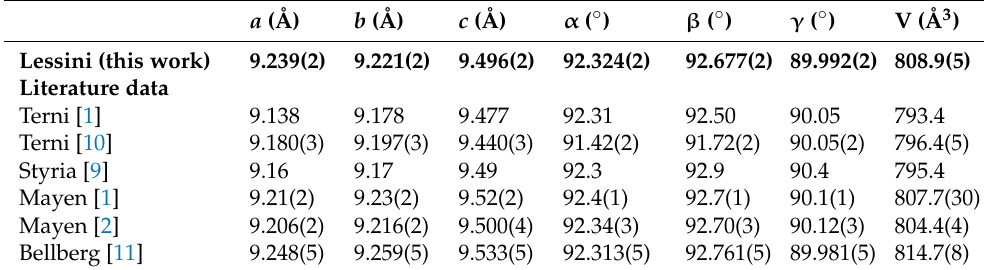
Table 4. Unit-cell parameters of willhendersonite from the Lessin Mounts, compared with literature data. Values of estimated standard deviations are given in